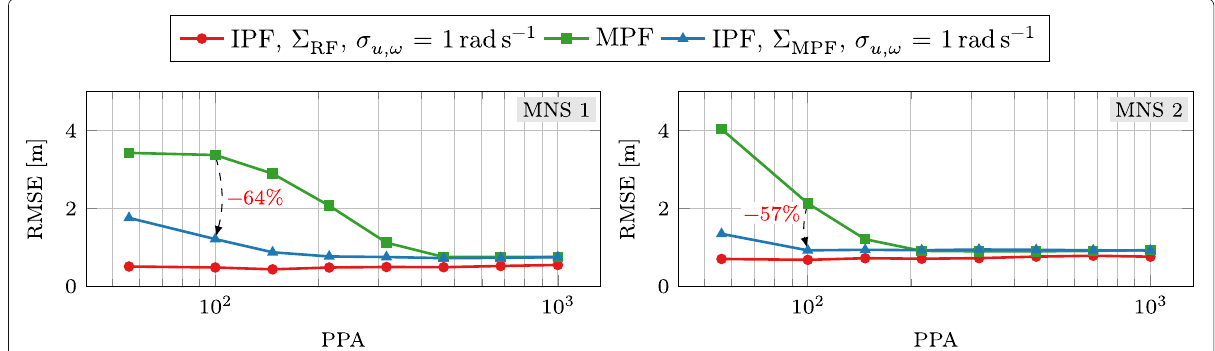
Fig. 7 Comparison between the MPF and IPF algorithms for σ u , ω = 1rad s − 1 and varying state PPA values. The left panel shows the results for MNS 1, and the right panel shows the results for MNS